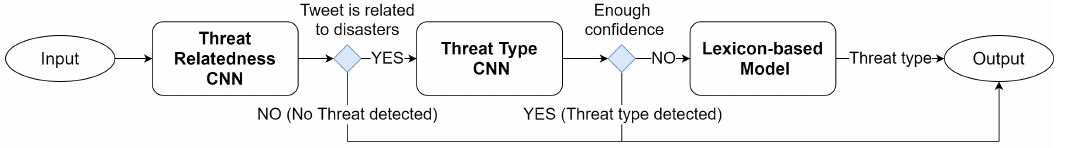
Figure 2. Disaster extraction component